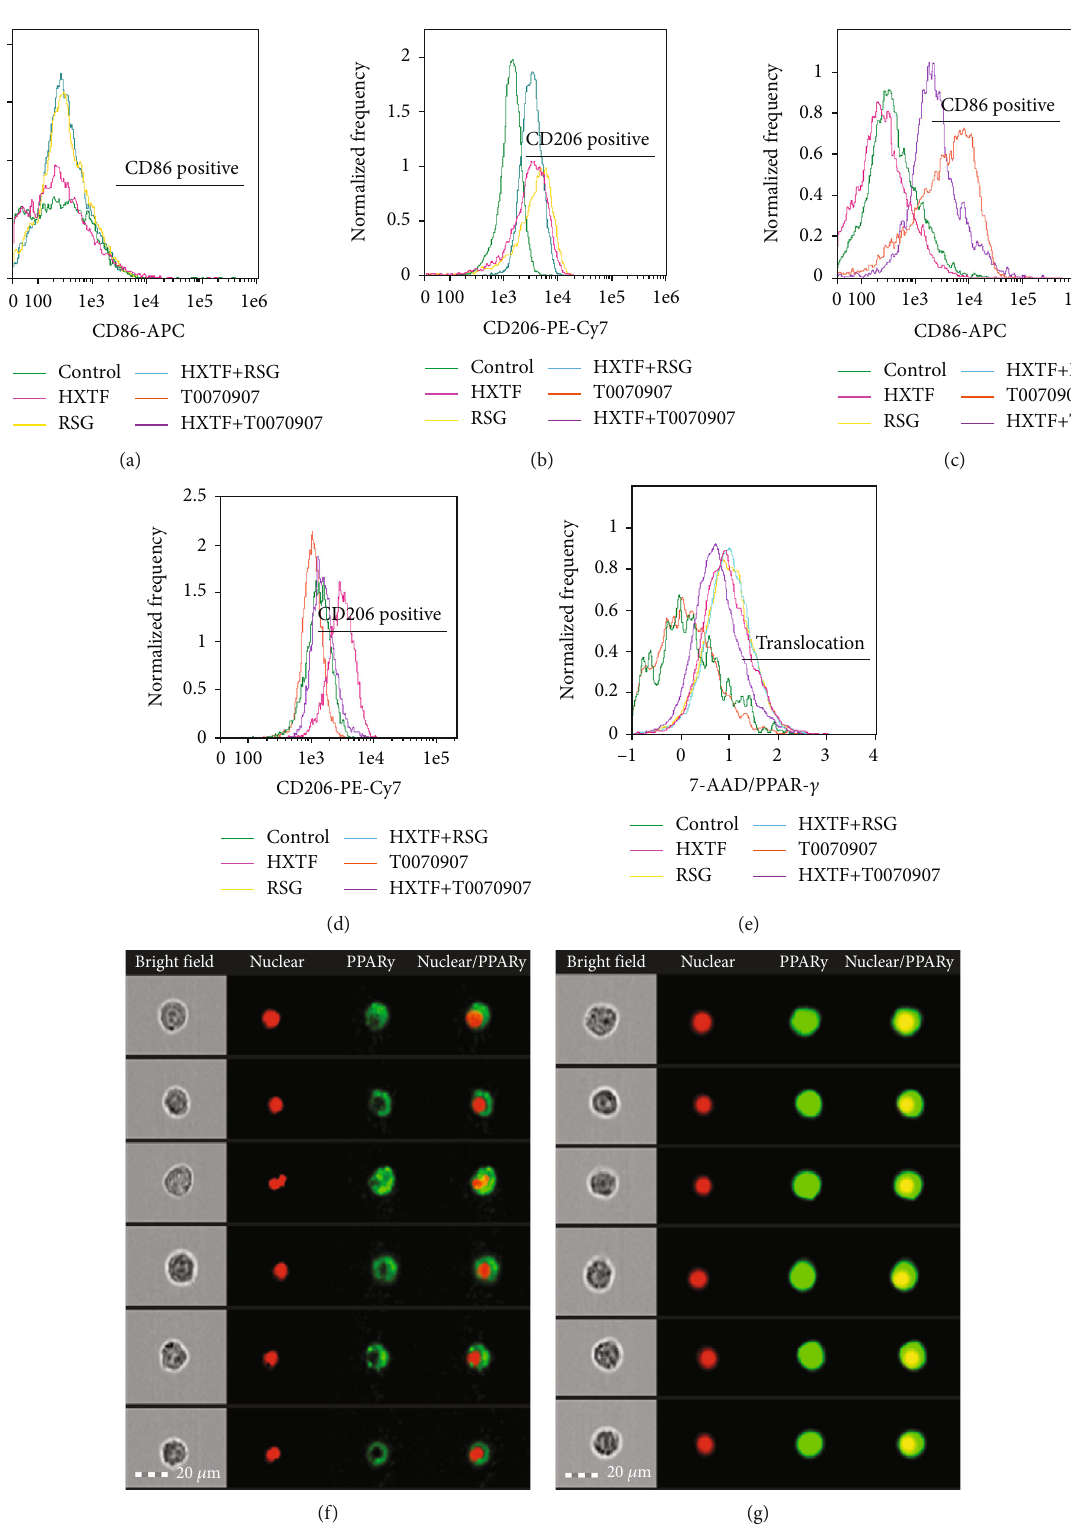
Figure 5: Modulation of PPAR- γ activity on macrophage polarization and PPAR- γ nuclear translocation. RAW264.7 cells were preincubated with either rosiglitazone (RSG) (1 μ mol/mL) or T0070907 (1 μ mol/mL) for 3h, followed by combined treatment with/without HuoXueTongFu Formula (HXTF) for 12h. (a, b) Flow cytometry analysis of M1/M2 marker CD86 and CD206 expression in control, HXTF, RSG, and HXTR+RSG group. (c, d) Flow cytometry analysis of M1/M2 marker CD86 and CD206 expression in control, HXTF, T0070907, and HXTF+T0070907 group. (e) Flow cytometry analysis of PPAR- γ nuclear translocation. (f) Typical cell fi gures of nuclear untranslocation. (g) Typical cell fi gures of nuclear